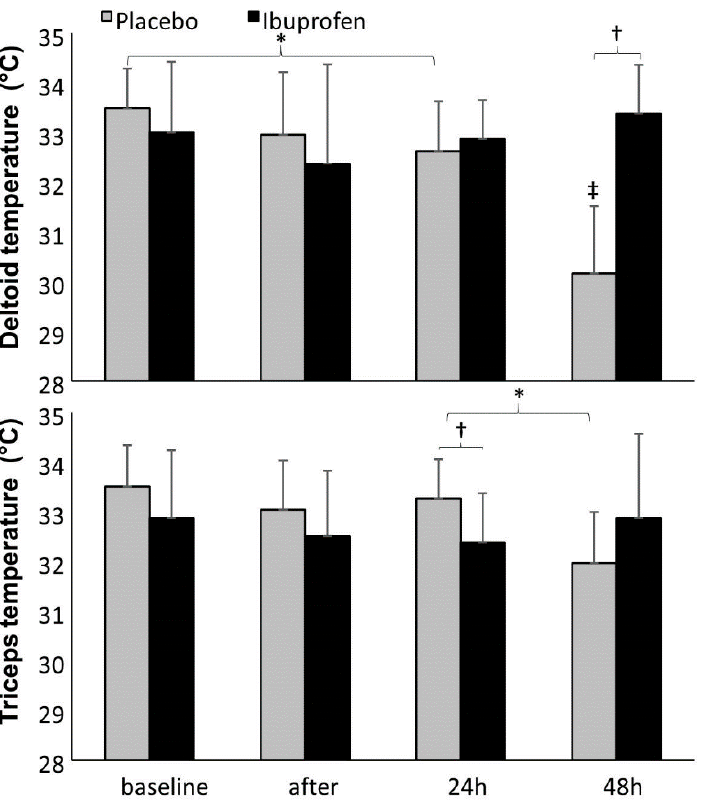
Figure 3. Mean ( ± SD) deltoid and triceps muscle temperature before, straight after, post-24 h and post-48 h after a heavy bench press with placebo vs. ibuprofen ingestion protocol. * = significant di ff erence between these two testing times for this condition ( p < 0.05); † = significant di ff erence between these two conditions ( p < 0.05); ‡ = significant di ff erence with all other testing times for this condition ( p < 0.05).